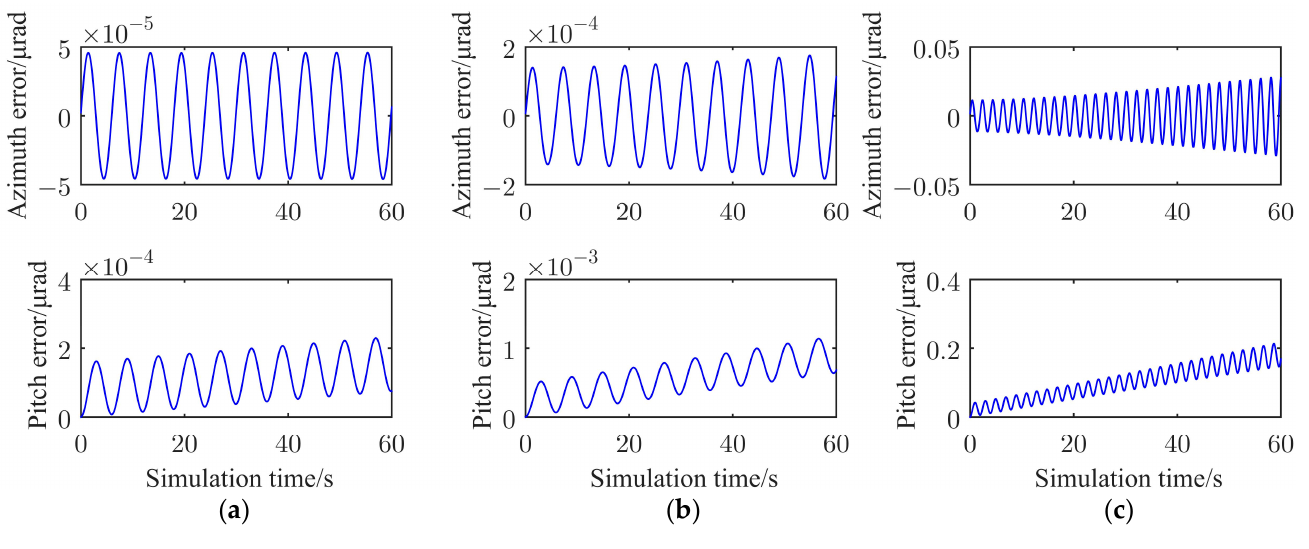
Figure 18. The error curve of the calculation of the indirect numerical calculation method in the re fl ector coordinate system O 46 X 46 Y 46 Z 46 . ( a ) a = 1°, ω = 60°/s; ( b ) a = 3°, ω = 60°/s; ( c ) a = 1°, ω = 180°/s. Table 1. The numerical calculation error ( µ rad) values (1 σ ) obtained using the indirect calculation